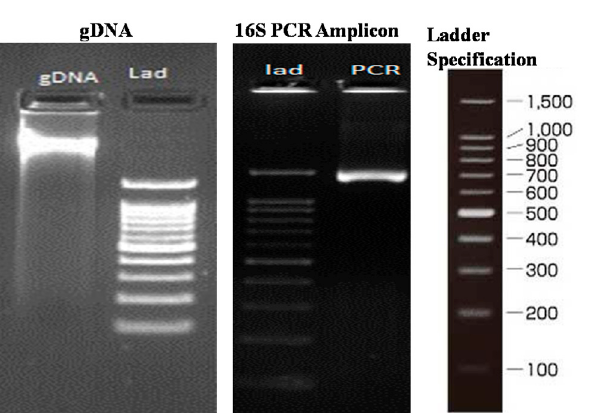
Fig. 6. Molecular characterization of the bacterial strains through 16S rDNA. (A) View of the genomic DNA and the Ladder, (B) 16S PCR Amplicon, and (C) The opted ladder